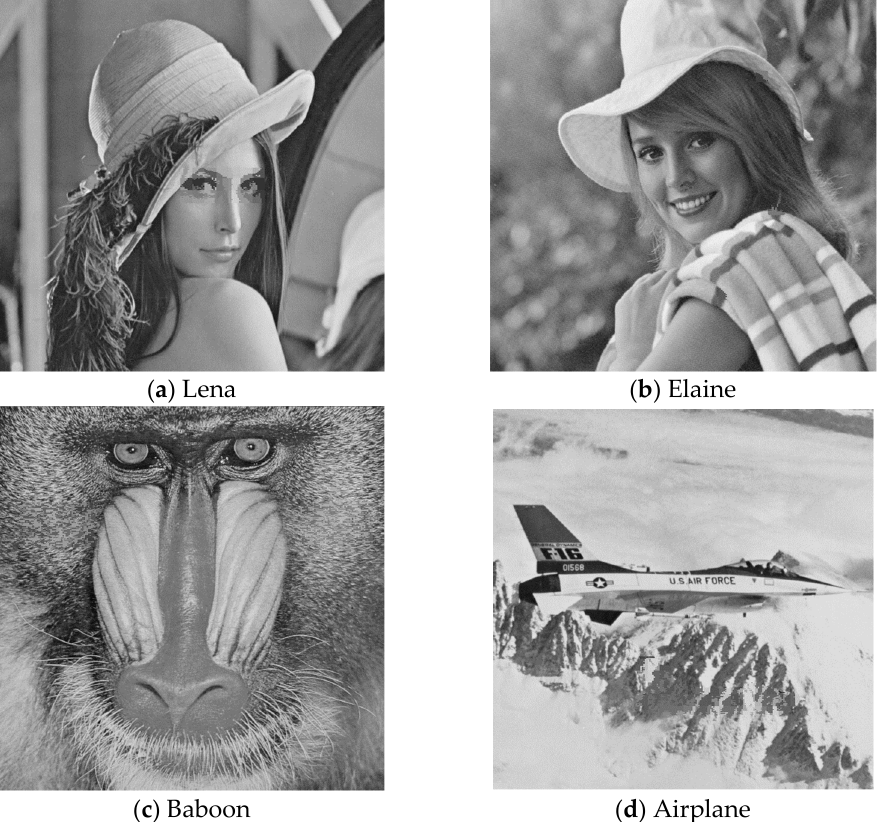
Figure 17. Four recovered images: ( a ) PSNR (cid:3404) 44.12 dB , ( b ) PSNR (cid:3404) 45.35 dB , ( c ) PSNR (cid:3404) 34.95 dB , and ( d ) PSNR (cid:3404) 42.69 dB . Table 6. Performance comparison of tamper detection and image quality against two types of at- tacks with different attack ratios .